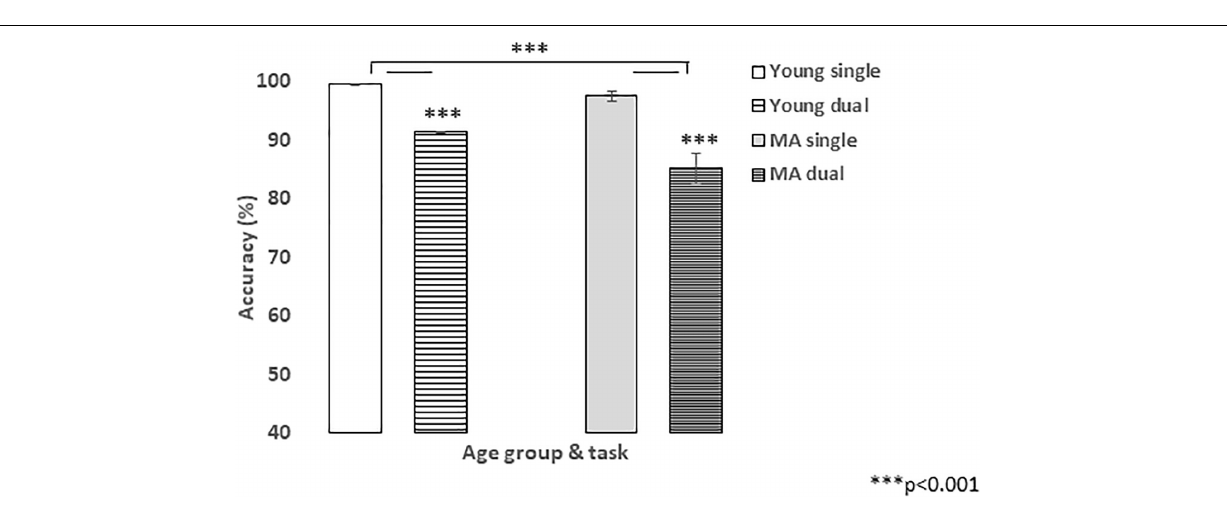
FIGURE 3 | Mean ( ± se) of visual task accuracy in the single (solid) and dual (pattern) tasks for Young (white) and MA (gray) groups.